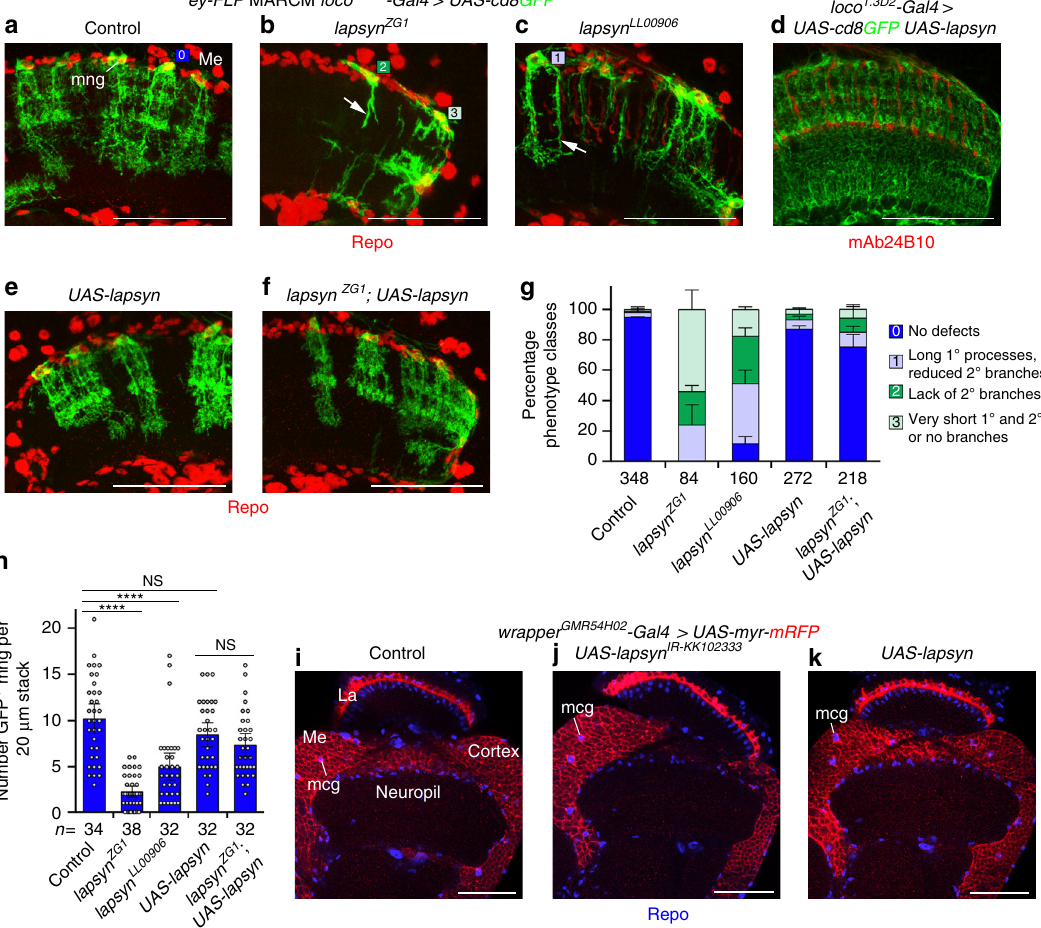
Fig. 5 lapsyn is cell-autonomously required for branch morphogenesis of astrocyte-like mng. a – c Control, lapsyn ZG1 and lapsyn LL00906 mutant astrocyte-like mng clones were generated by combining ey-FLP and MARCM. Clones were labeled with loco 1.3D2 -Gal4 UAS-cd8GFP ( green ) and all glial nuclei with Repo ( red ). Unlike control clones displaying a highly elaborate morphology ( a , square-0 ), lapsyn mutant astrocyte-like mng showed severe defects: primary and secondary processes were very short ( b , square-1 ), secondary branches were missing ( b , square-2 ) or reduced ( c , square-3 ). d , e Overexpression of UAS- lapsyn with loco 1.3D2 -Gal4 in all astrocyte-like glia ( d ) or in MARCM clones ( e ) did not affect general mng morphology. f Overexpression of UAS-lapsyn rescued morphological defects in lapsyn mng clones. g Quanti fi cation of phenotype classes. 100% stacked bar histograms show data points as means plus standard deviation error bars ( n = independent experiments assessing individual mng in 20- µ m optical stacks/optic lobes: 3 [34/19], 3 [38/24], 2 [32/18], 3 [32/17], 3 [31/16]). Color code same as in a – c . h Quanti fi cation of GFP-positive astrocyte-like mng numbers. In adults, fewer clones were recovered in lapsyn mosaics compared to controls. Overexpression of UAS-lapsyn does not affect cell numbers and rescues the reduction of clones in lapsyn ZG1 . The scatter plot with bars shows data points and means ± 95% con fi dence intervals ( n = 20- μ m stacks of optical sections from 19,24,18,17, and 16 optic lobes). Unpaired, two-tailed Student ’ s t- test not assuming equal variance: P = 2.93 × 10 − 12 , P = 6.44 × 10 − 6 , P = 0.0882, P = 0.2131. NS not signi fi cant, **** P < 0.0001. i – k Knockdown and overexpression of lapsyn in medulla cortex glia ( mcg ) using wrapper GMR54H02 -Gal4 to express UAS-lapsyn IR - KK102333 ( j ) or UAS-lapsyn ( k ) does not affect their morphology compared to controls ( i ). La lamina, Me medulla. Panels d , i – k show single optical sections, a – c , e , f projections. For genotypes, sample numbers and additional statistical values, see Supplementary Tables 1 and 2. Scale bars , 50 μ m ( a – f , i – k